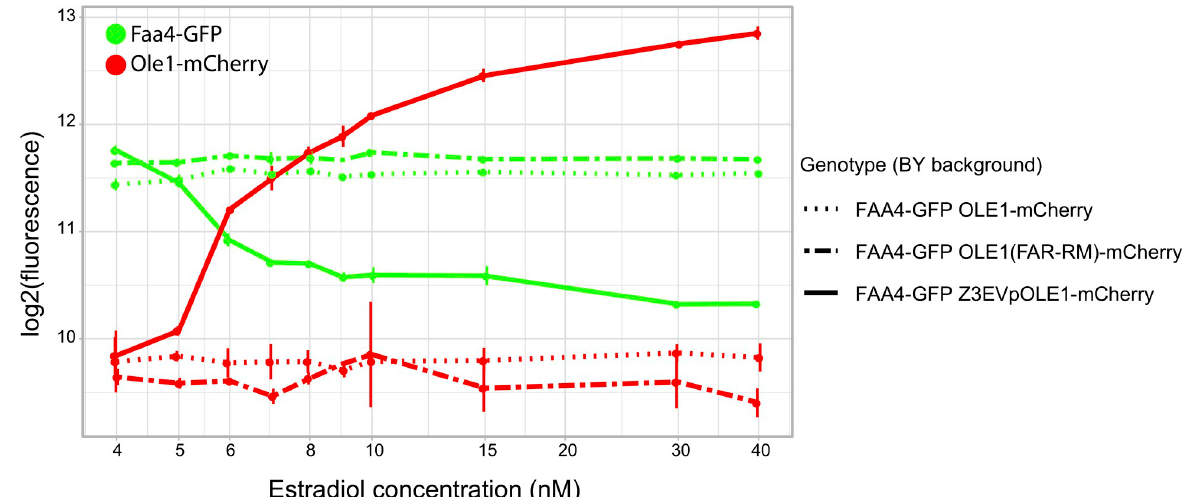
Fig 6. Expression modulation of Ole1. Fluorescence levels of Ole1-mCherry (solid red lines) under control of the estradiol-inducible Z 3 EV promoter and Faa4-GFP (solid green lines) under its native promoter at various estradiol doses. For comparison, fluorescence levels of strains with the native OLE1 promoter with the FAR-BY or FAR-RM allele are shown as dotted and dashed lines, respectively. All strains harbor both the mCherry tag on Ole1 and the GFP tag on Faa4. Measurements are shown as mean (dots) and standard deviations (vertical lines).